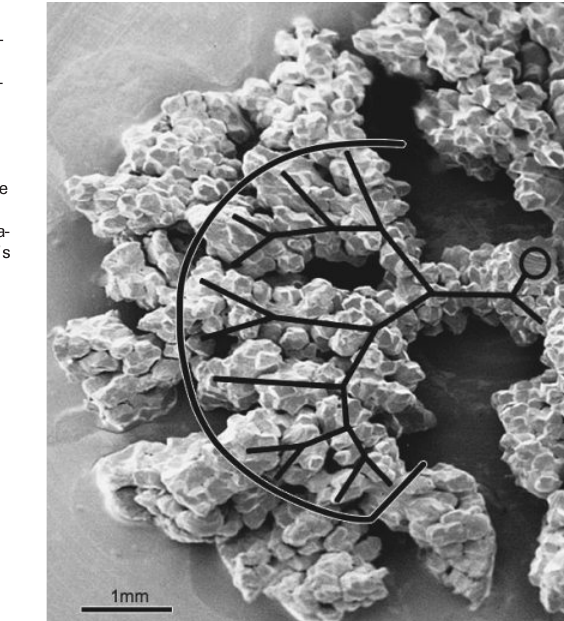
Alveolar ducts in aci- nus of human lung shown in silicon rub- ber cast spread out to show the course of the subsequent branchings.The curved line marks the approximate bound- ary to the last genera- tion, to show that this generation of alveo- lar sacs comprises over half the gas ex- change area of the